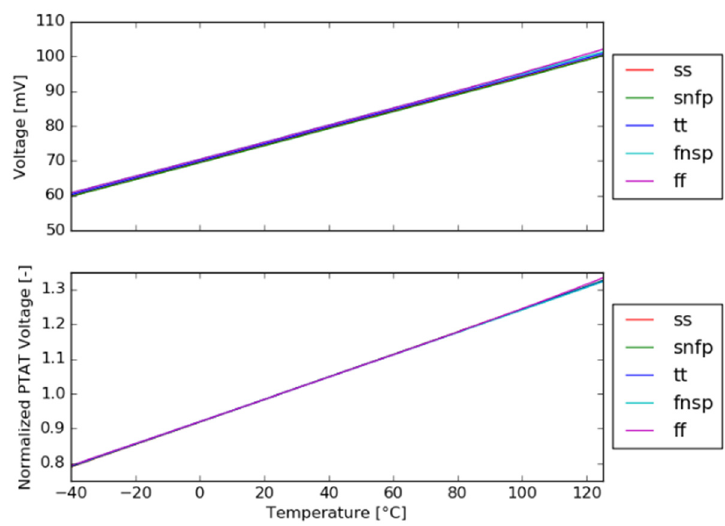
Figure 12. Process corner simulation of PTAT output voltage.